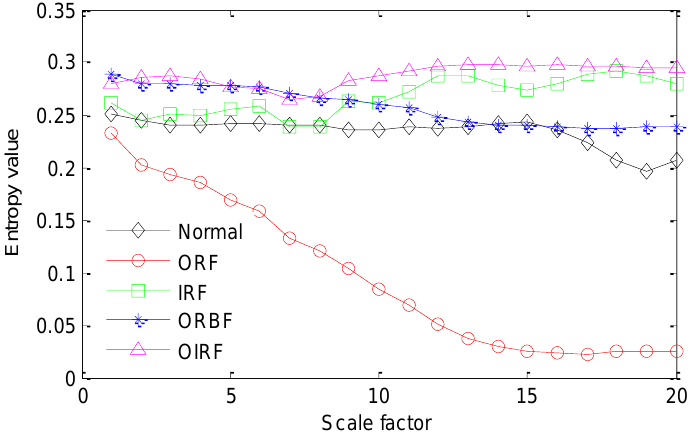
Figure 15. Calculation result of IMSDE for one data sample of each category.